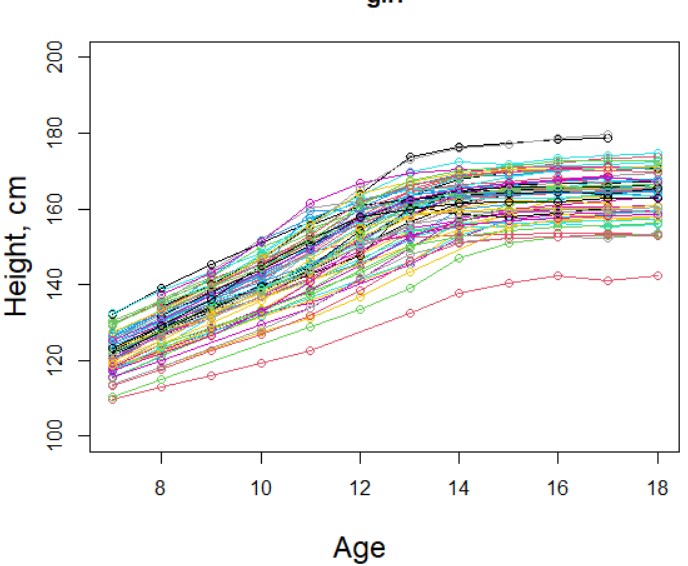
Figure 1. The height of girls aged from 7 to